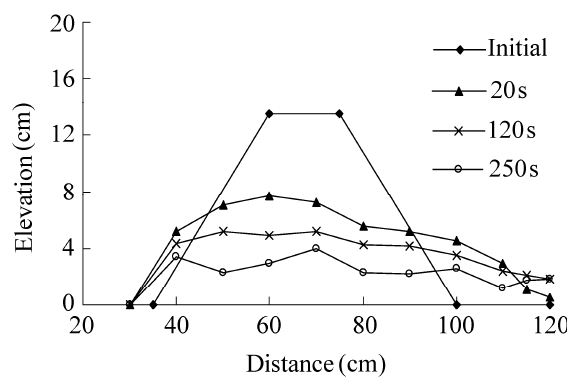
Fig. 12 Relationship between breach width and sediment grading. Fig. 10 Changing process of the breach cross-section along the flow.